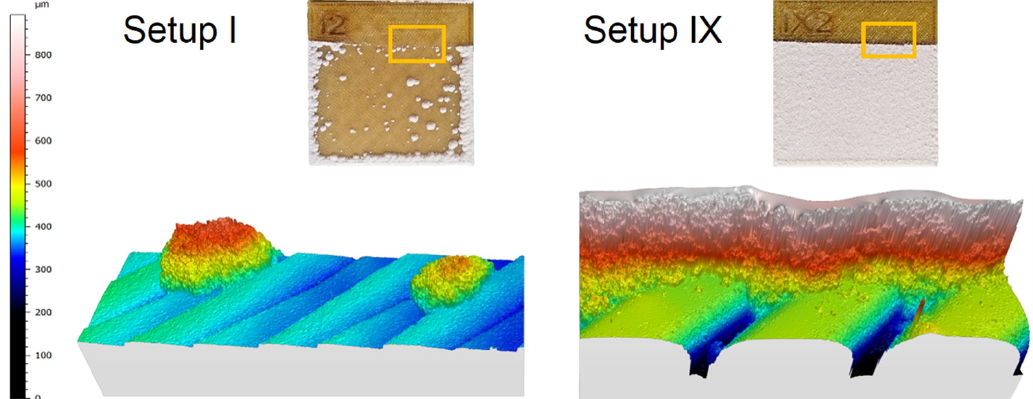
Figure 8. Surfaces after APS deposition for setup I ( left ) and setup IX ( right ).